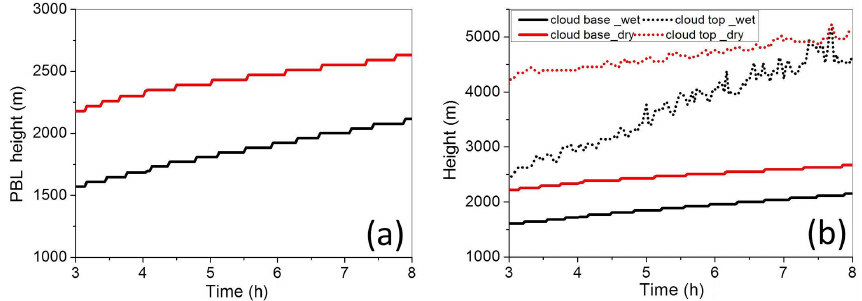
Figure 10. Evolution of (a) the planetary boundary layer (PBL) height and (b) the cloud base and cloud top heights from dry and wet simulations of the IGOC field project. Red/black lines are for the dry/wet